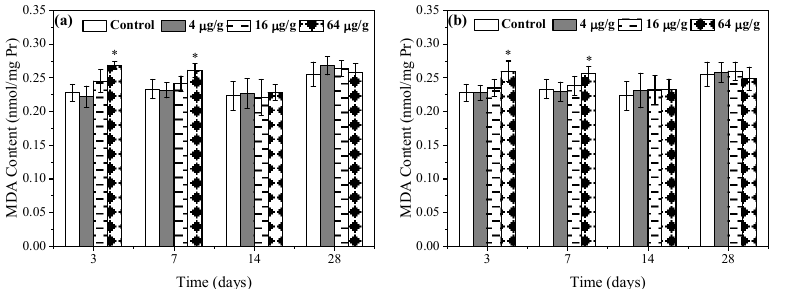
Figure 3. Effects of Rac - ( a ) and S -metolachlor ( b ) on MDA content in E. fetida . * p < 0.05 indicates the statistical significance between the control group and treatment group at the same exposure time.